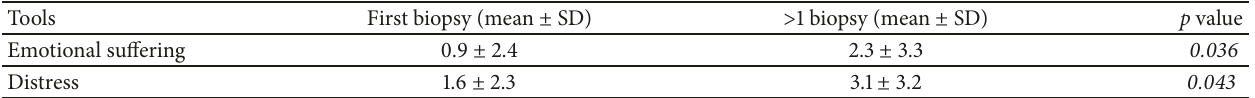
Table 2: Thermometer scores comparison according to previous biopsy at Time